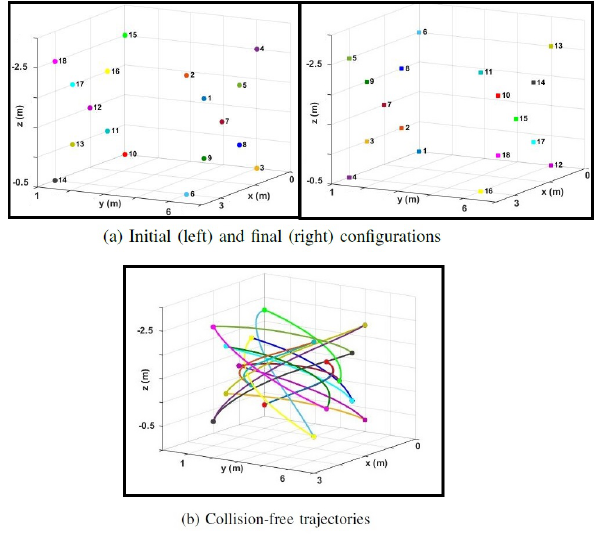
Figure 8. ( a ) Initial (left) and final (right) position configurations for 18 drones. Each drone is assigned a unique color and a number next to it. ( b ) Collision − free trajectories for 18 drones switching their positions in a 3 m × 5 m × 2 m space. The total flight time for the drones to reach their final positions is 5.1 s using the proposed method, which is shorter than the 6.3 s flight time obtained with the